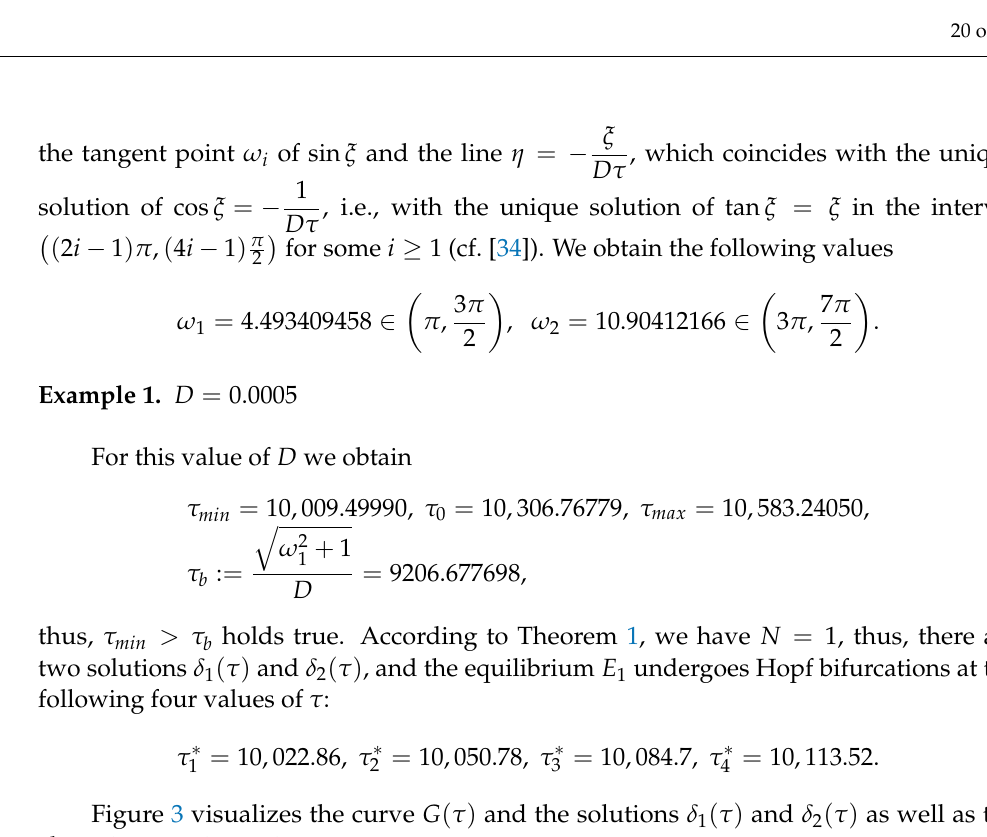
Figure 3 visualizes the curve G ( τ ) and the solutions δ 1 ( τ ) and δ 2 ( τ ) as well as the above intersection points.